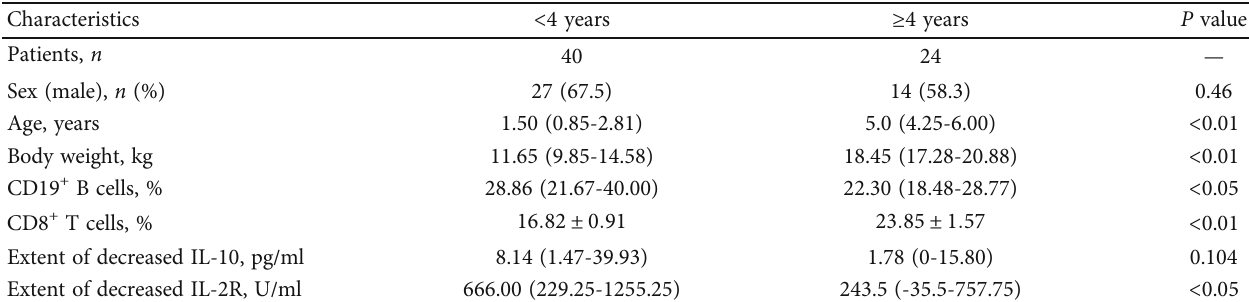
Table 2: Clinical and biochemical characteristics of children with Kawasaki disease in di ff erent age groups.